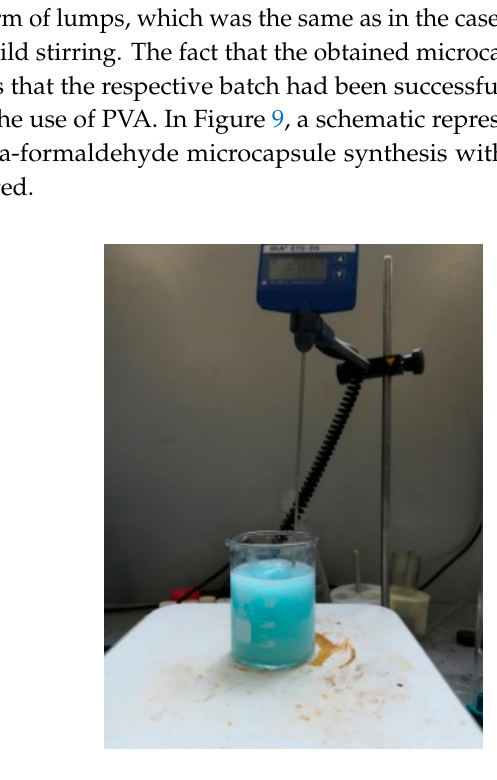
Figure 9. Schematic illustration of melamine-urea-formaldehyde microcapsule synthesis with embedded 5-ethylidene-2-norbornene as repair agent. During the synthesis, at about 30 min after the addition of the monomer, a sample was collected to control the synthesis process. After 12 h at room temperature, small traces of water were still visible, which eventually dried out after 24 h. The red highlighted areas in Figure 10 a represent microcapsules that were broken to observe their behavior. It was observed that when the microcapsules were broken, the healing agent evaporated and the specific area tended to darken. Therefore, the process proceeded in optimal conditions and the MUF microcapsule synthesis was performed successfully. After 24 h at room temperature for drying, a quantity of 22 g of microcapsules was obtained. In the microstructural analysis, a major difference in the size of the microcapsules was observed between the two processes. It could be easily observed that most of the obtained microcapsules were smaller than 100 µm for the MUF-ENB system. This represents a favorable outcome, as the MUF- ENB system will be easier to integrate in the matrix and composite material.